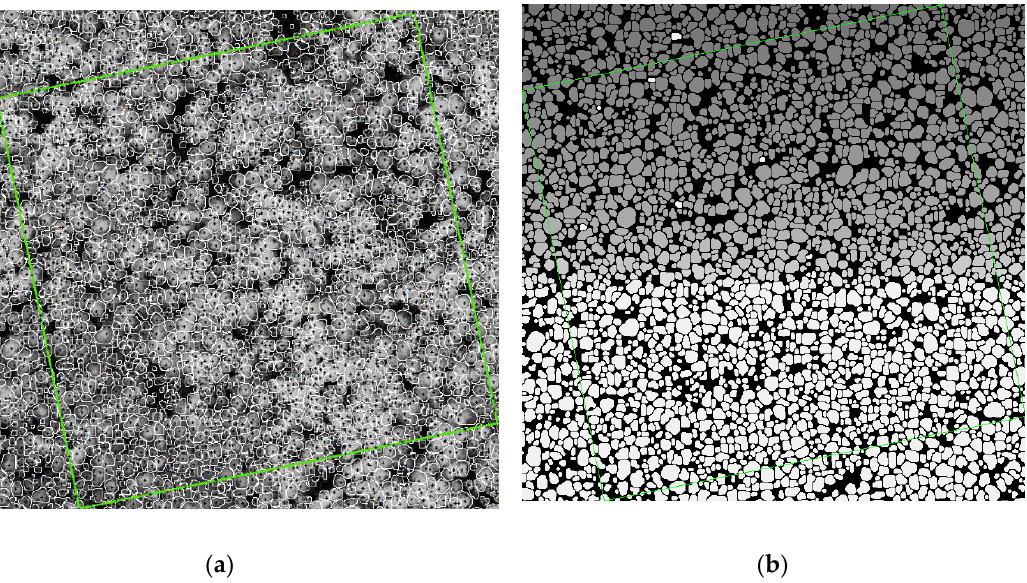
Forests 2019 , 10 , x FOR PEER REVIEW Figure 4. Individual tree isolation results and label image. ( a ) individual tree isolation results; ( b ) individual tree label image.